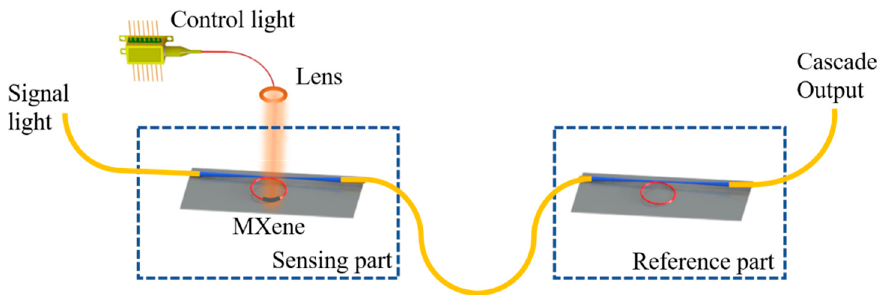
Figure 4. Experimental setup of photothermal fiber sensor based on MKR and MXene-MKR cascade.